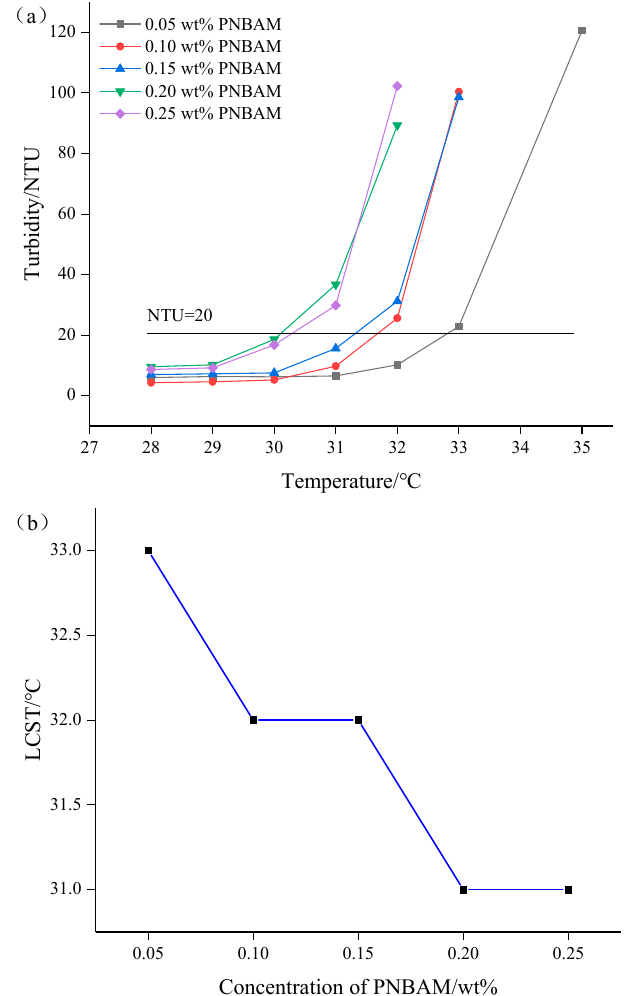
Figure 8. Effects of the concentration (wt%) on turbidity change with temperature ( a ) and LCST ( b ) of PNBAM aqueous solution.